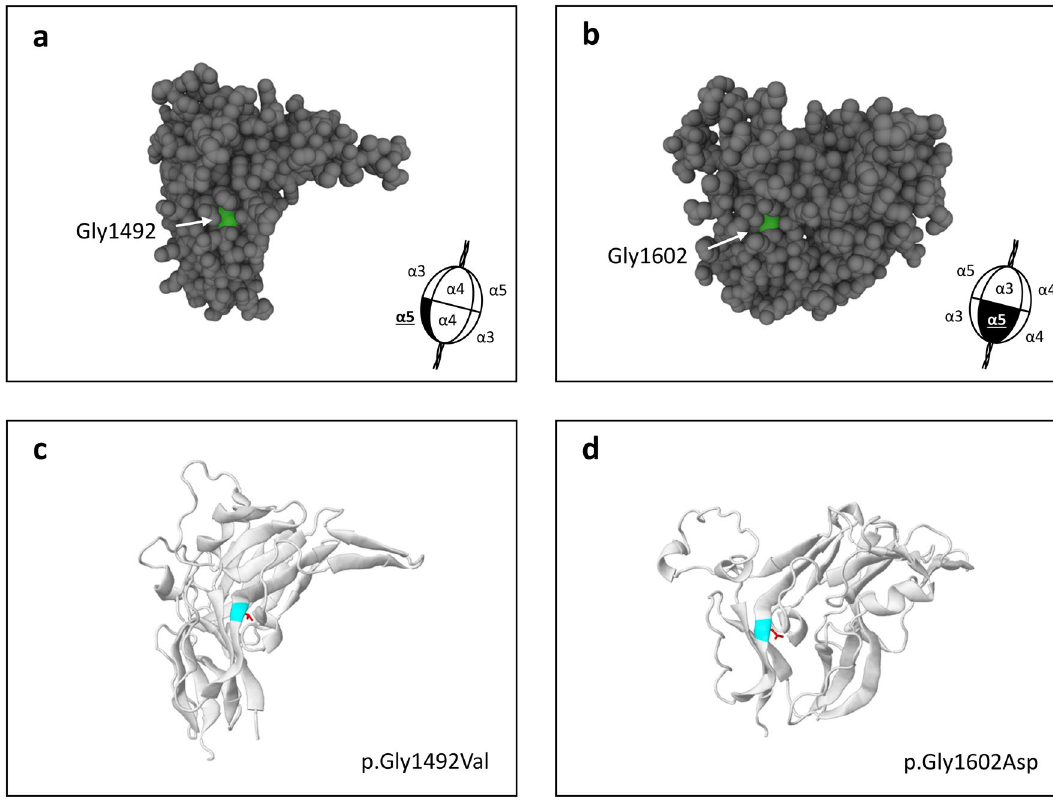
Figure 4. (a,b) Space-filling models showing the location of the two commonly affected buried Gly residues (shown in green) within the collagen IV α5 NC1 domain. Models were produced using UniProt (https:// www. unipr ot. org/). (c,d) Ribbon diagrams showing the effect of two substitutions affecting these buried Gly residues (shown in blue). In both cases the affected residue is located within a β-strand, where the larger side-chain of the substituting residue (shown in red) encroaches upon the neighbouring secondary structure. Diagrams were produced using JSmol, accessed through Missense3D (http:// misse nse3d. bc. ic. ac.